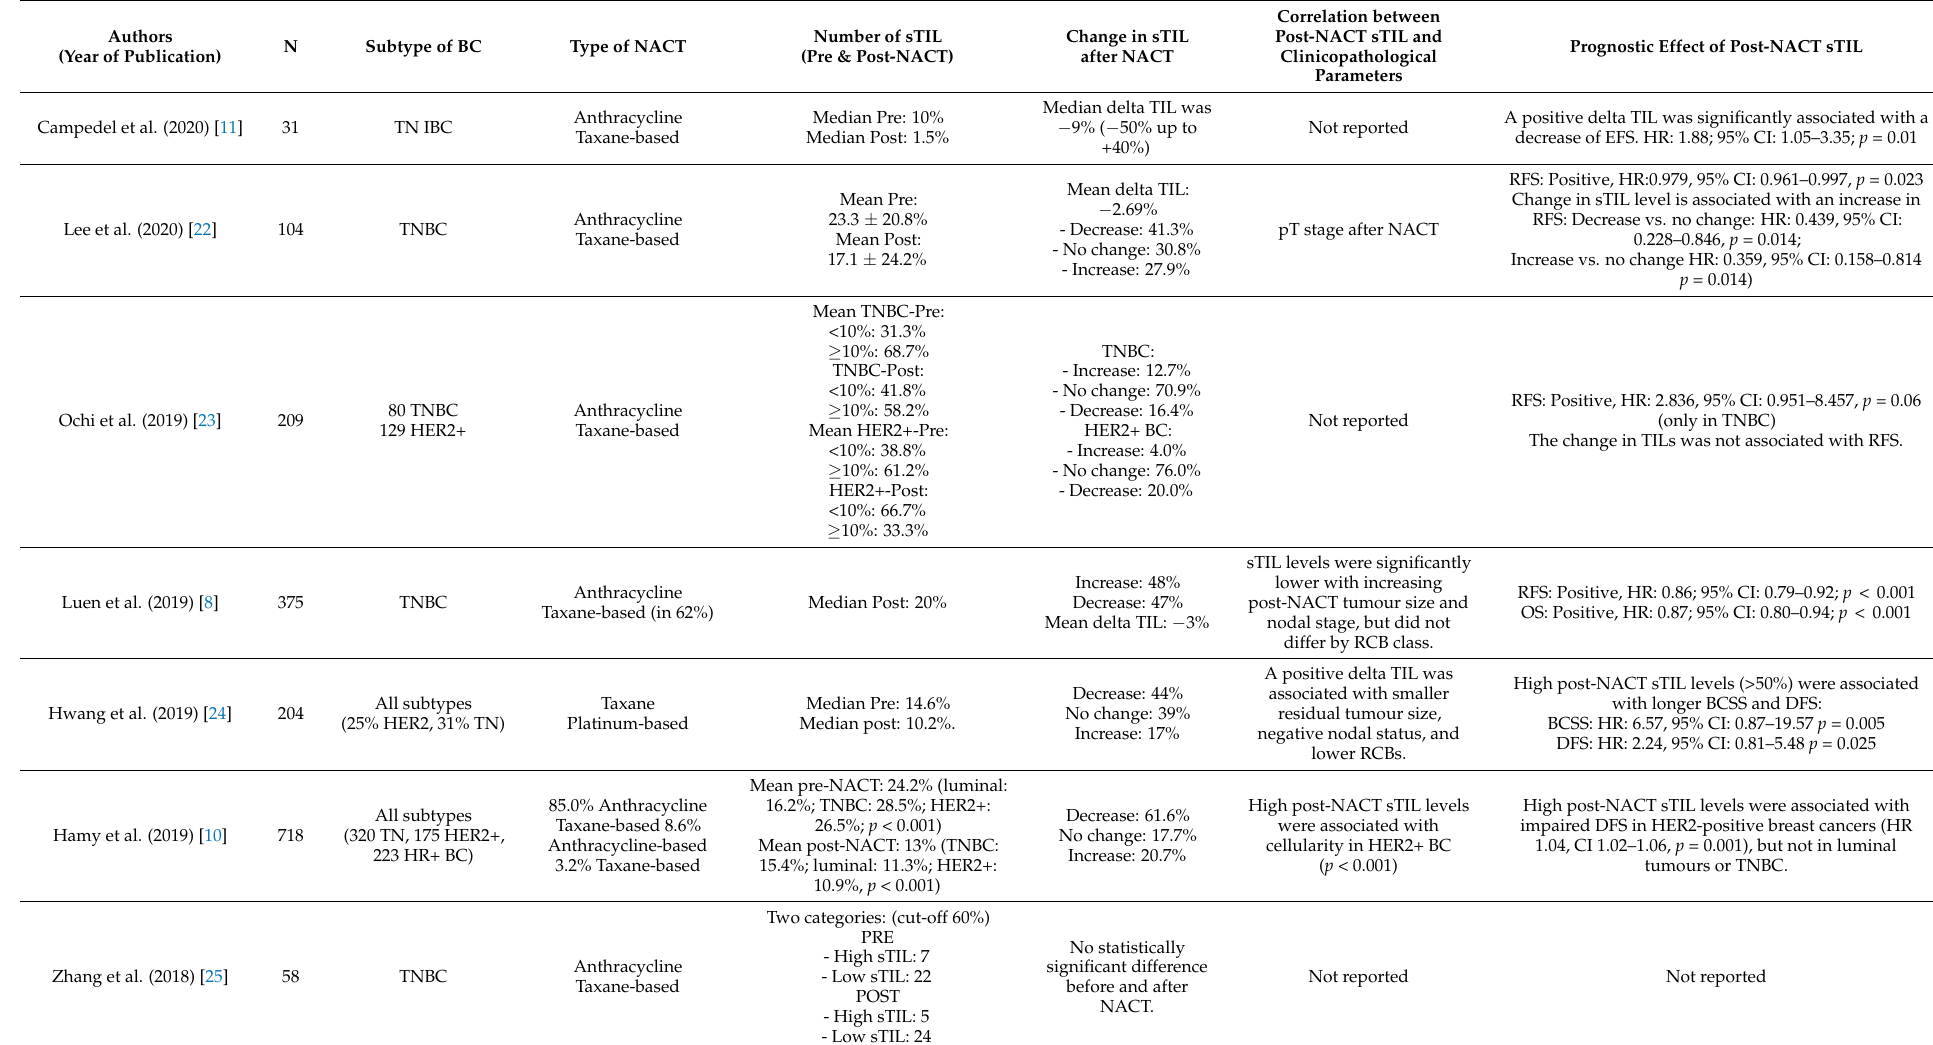
Table 1. Evolution of sTIL in breast cancer after NACT and the prognostic